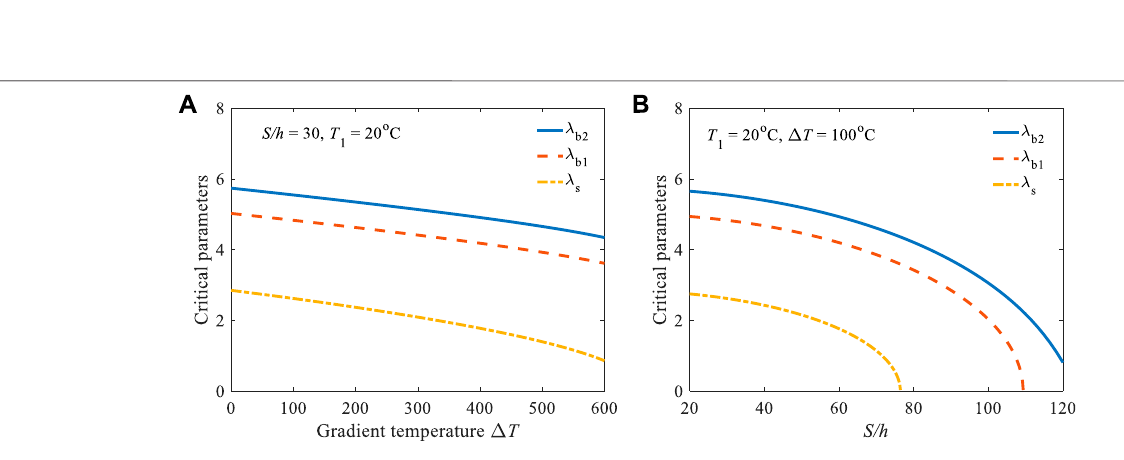
Frontiers in Materials |